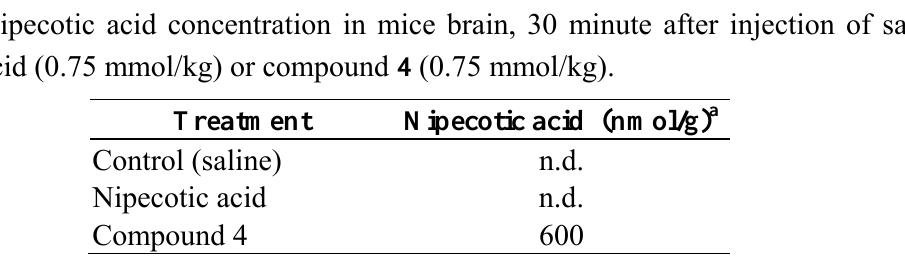
Table 2. Nipecotic acid concentration in mice brain, 30 minute after injection of